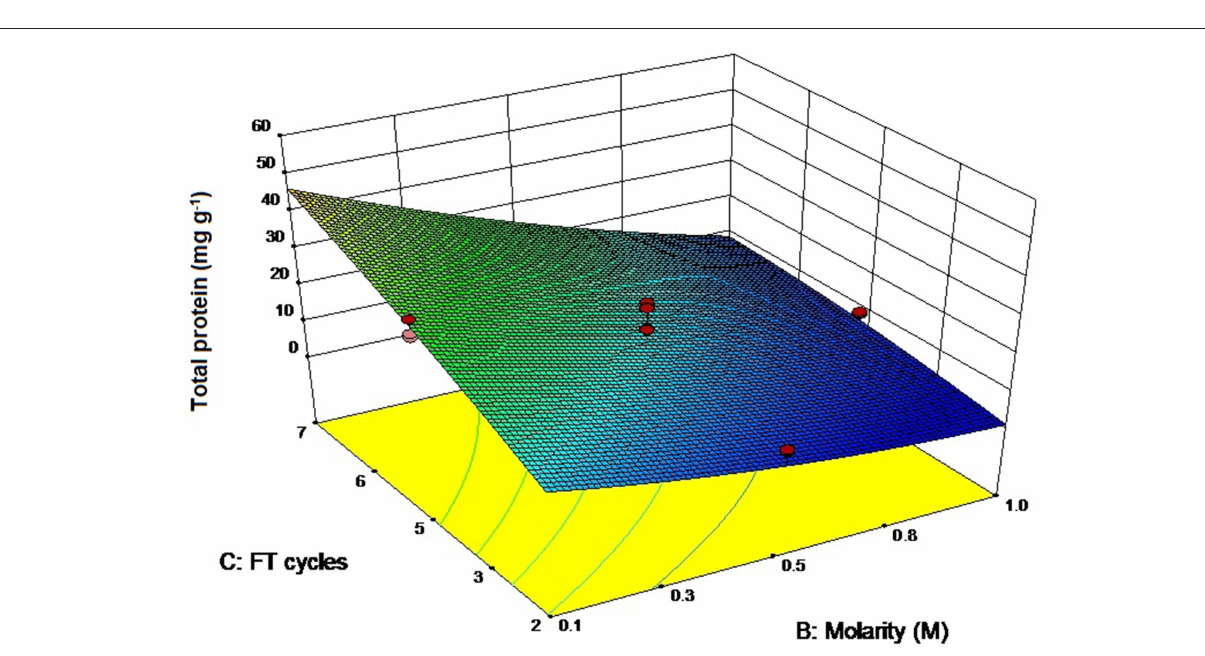
the extraction of CPE. Soni et al. (2008) have reported total protein values of 4.3 mg g − 1 from Phormidium fragile using the freeze thaw extraction method. In comparison, we were